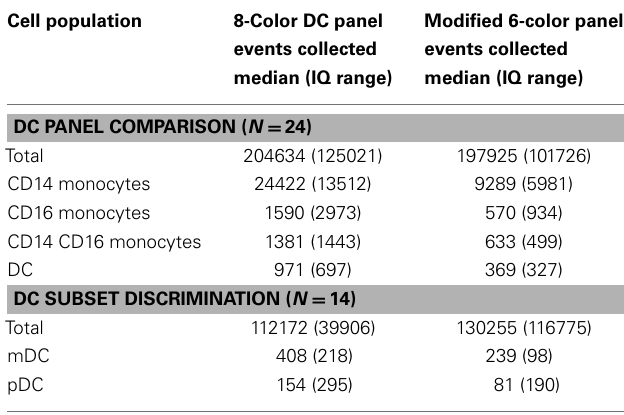
Table 2 | Flow cytometry events recorded for analysis of monocyte and DC subsets